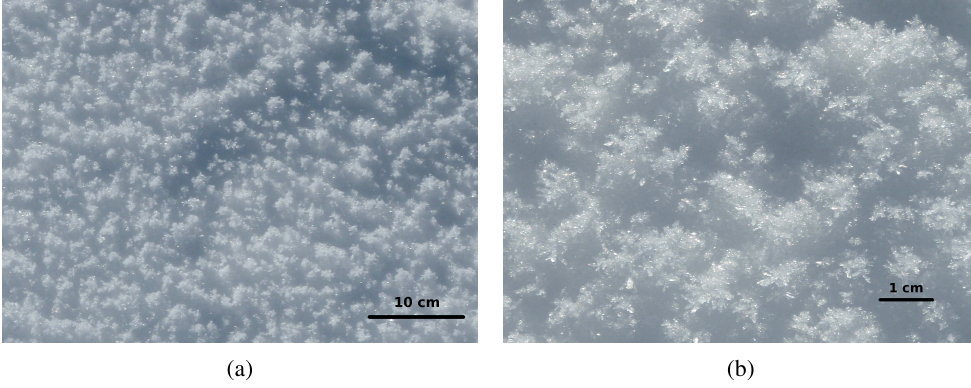
Fig. 1. Pictures of hoar at Dome C: (a) wide view (b) close view. Taken by hand with a normal camera on 30 December 2011.